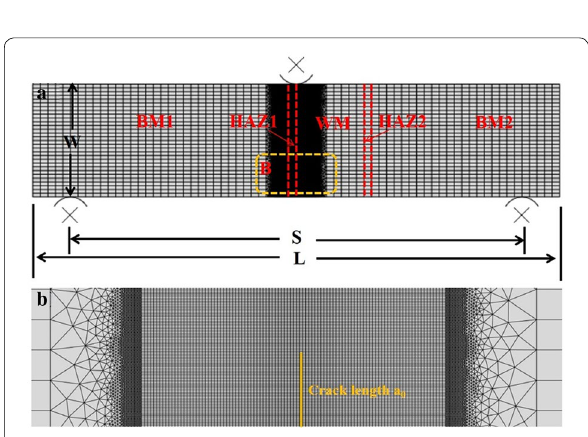
Figure 3 Geometry of SENB specimens and mesh division